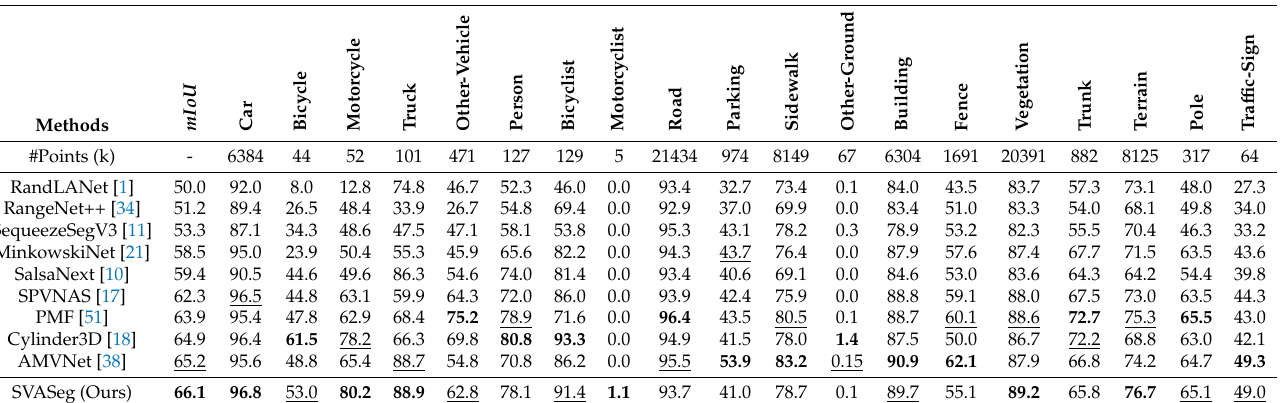
Table 1. Experimental results of our proposed SVASeg and other LiDAR segmentation methods on the SemanticKITTI dataset validation set. All results were obtained from the literature. Best and second best results are bolded and underlined.